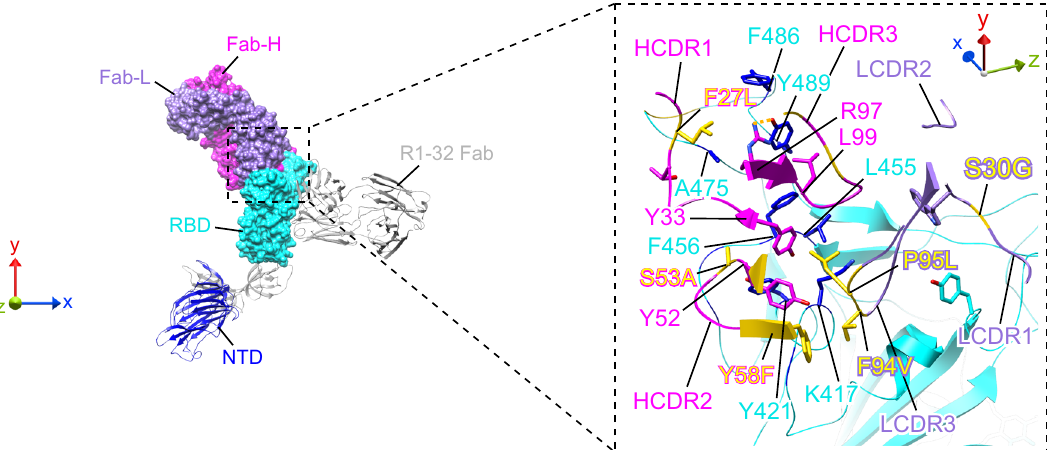
Fig. 3 | Structure complexes formed between YB9-258 and SARS-CoV-2 spikes reveal an antibody-antigen interface involving point changes introduced by somatichypermutation.a OmicronBA.1spike(S-6P)incomplexwithYB9-258Fab indifferentstoichiometriesandconformations. b Wildtypespike(S-6P)incomplex with YB9-258 Fab and R1-32 Fab. c S1 of disintegrated wildtype spike in complex with YB9-258 Fab and R1-32 Fab. Structures in a – c are low-pass fi ltered to 15Å to reveal fl exibleregions(alsoseeSupplementaryFig.5). d EpitopeofYB9-258Fabon